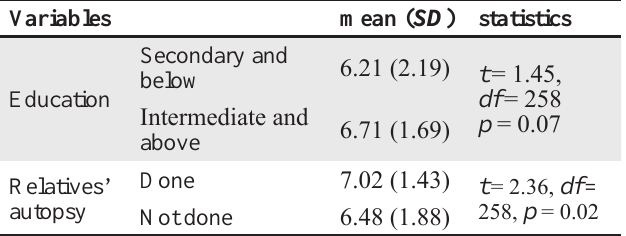
Table 4 : Relationship between knowledge of medico legal autopsy and other variables (N =